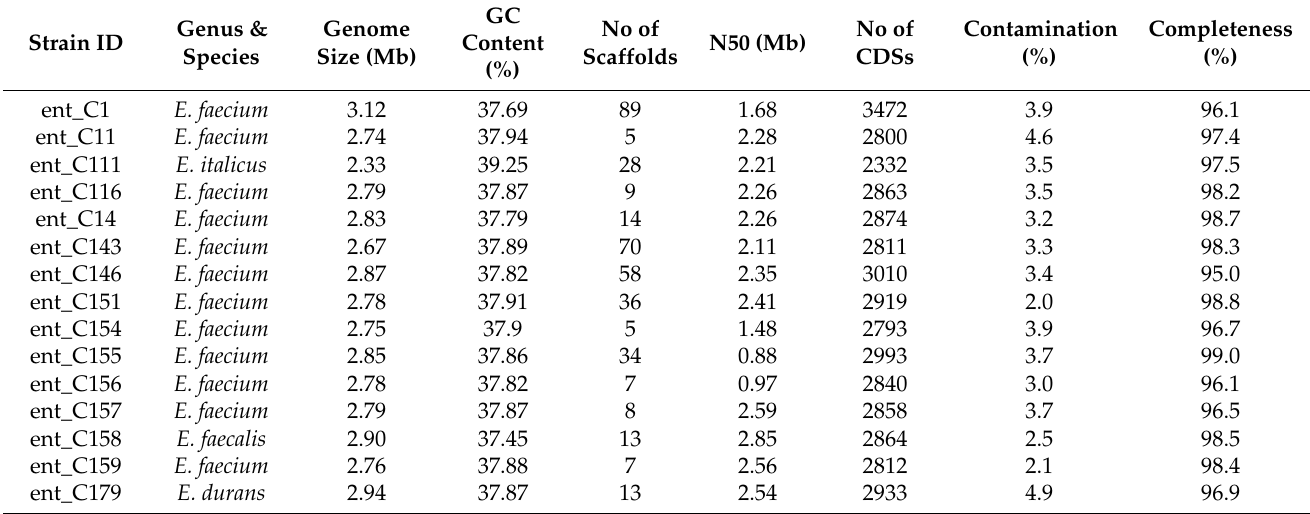
Table 1. Species identification and assembly statistics of the 30 Enterococcus spp.